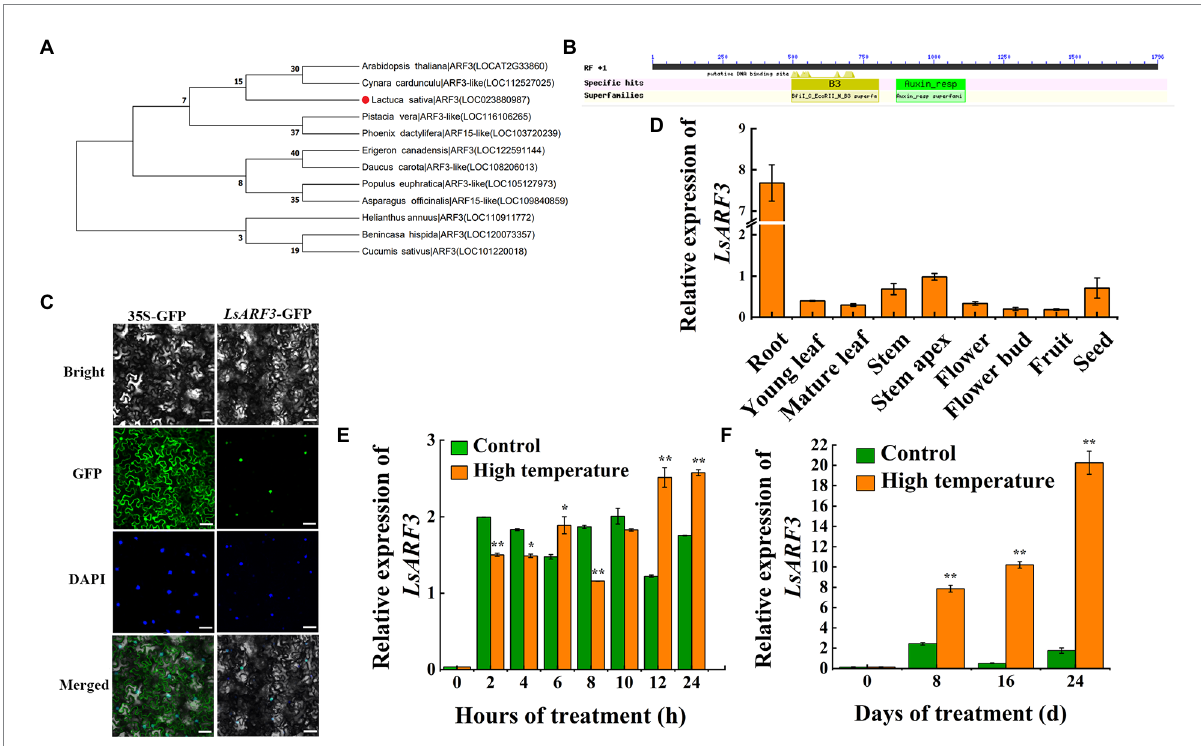
FIGURE 1 Identification and expression analysis of LsARF3 in lettuce. (A) Phylogenetic tree of LsARF3 protein. (B) Analysis of conserved domains of LsARF3 protein in lettuce. (C) Subcellular localization of LsARF3 fusion protein in lettuce cells. Plasmid with green fluorescent protein (GFP) alone served as the control. Bar = 50 μ m. (D) Expression level of LsARF3 in different organs of lettuce. Gene encoding 18 s rRNA was selected as the internal control. (E) Expression level of LsARF3 in stem apex within 24 h of high temperature stress. (F) Expression level of LsARF3 in stem apex